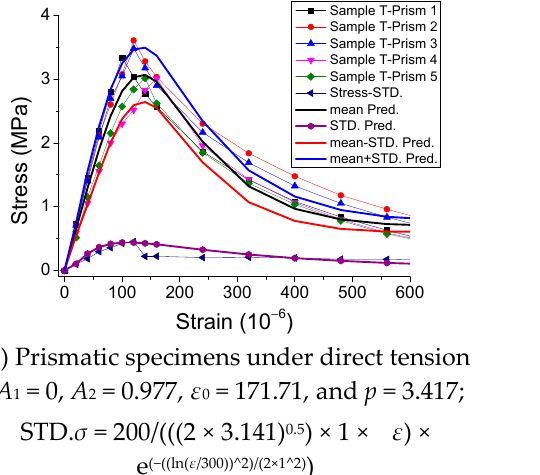
Figure 18. Stress-strain curves of SCC under monotonic loading. ( a ) Cube specimens under compression, ( b ) Prismatic specimens under compression, ( c ) Prismatic specimens under direct tension and ( d ) Mean σ - ε curve under direct